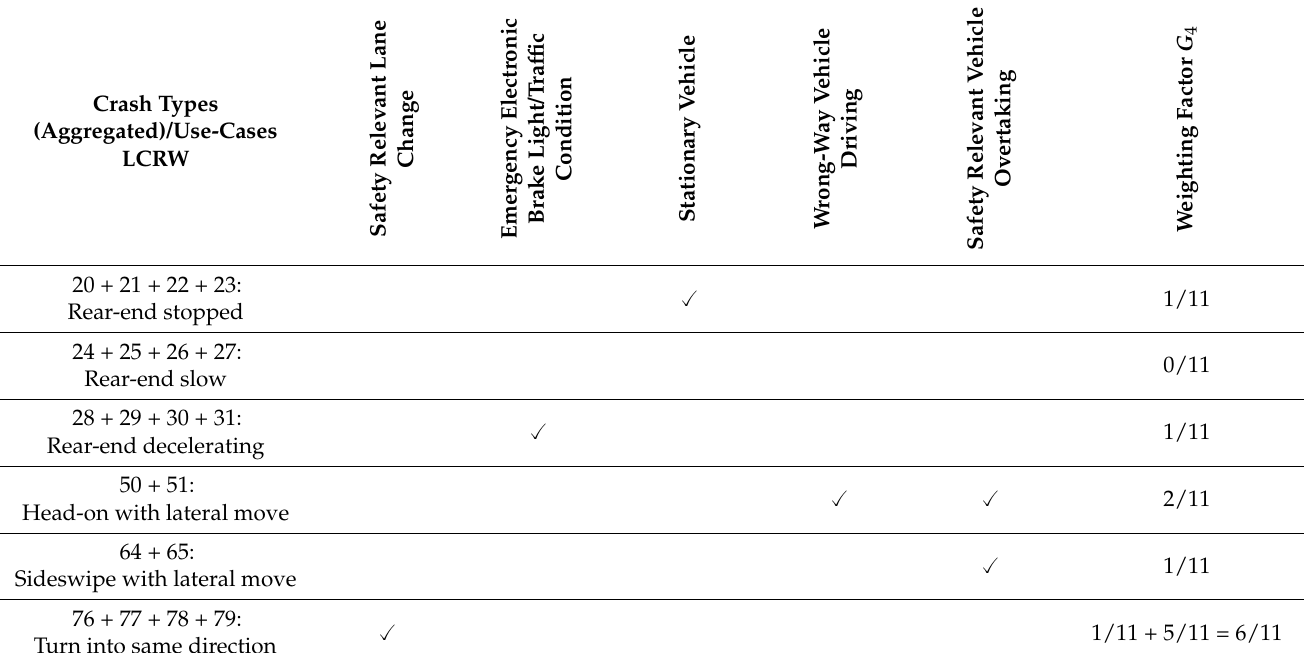
Table 7. Applicability of V2V + V2I use-cases of LCRW to the scenarios under investigation and calculation of the weighting factor